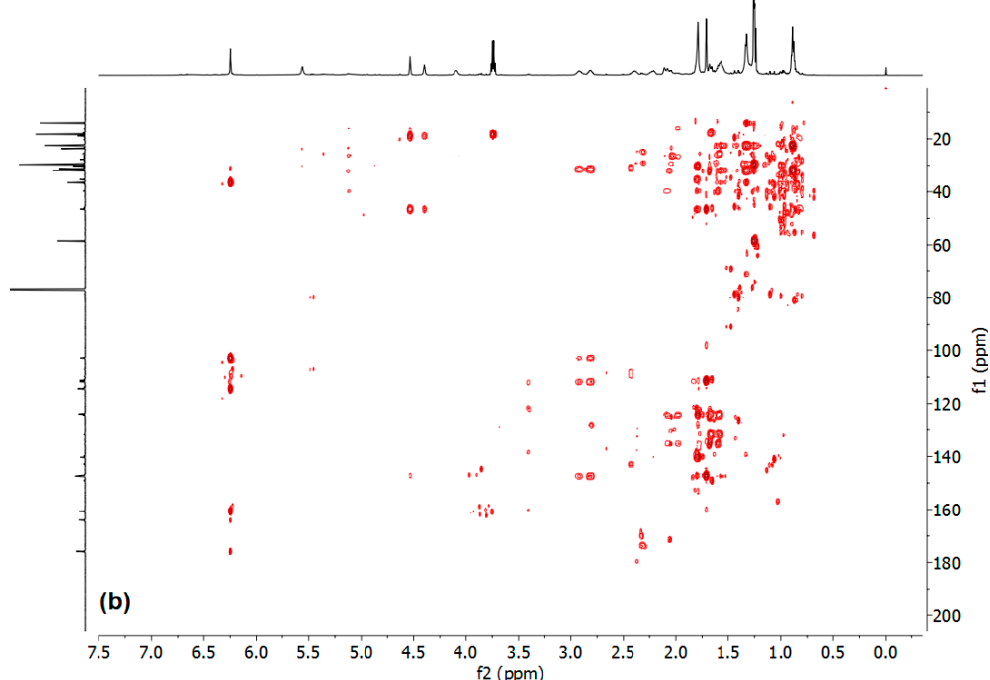
Figure 3. Typical HSQC ( a ) and HMBC ( b ) spectra of a hemp ethanolic extract.